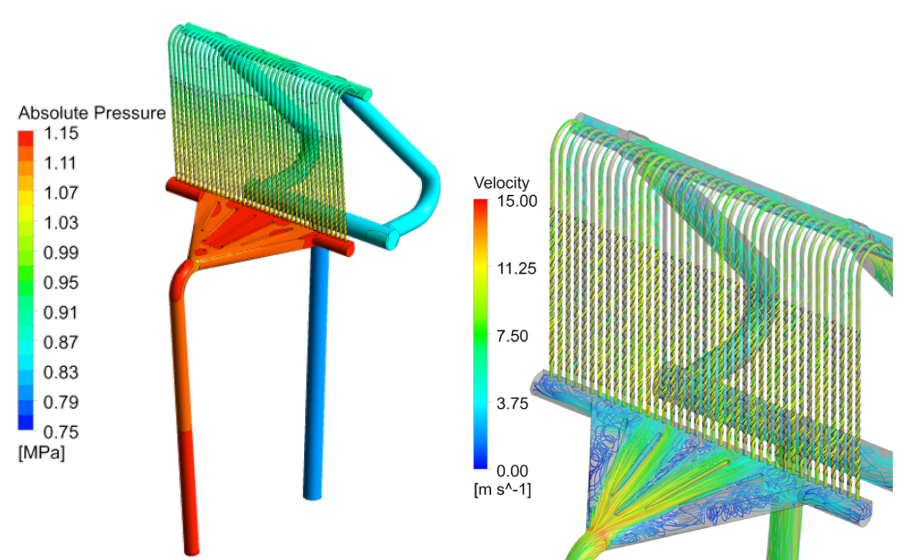
Figure 12. OVT mock-up results at G = 35.05 kg/s. OVT mock-up coolant total pressure field ( left ); OVT mock-up coolant flow velocity field ( right ).